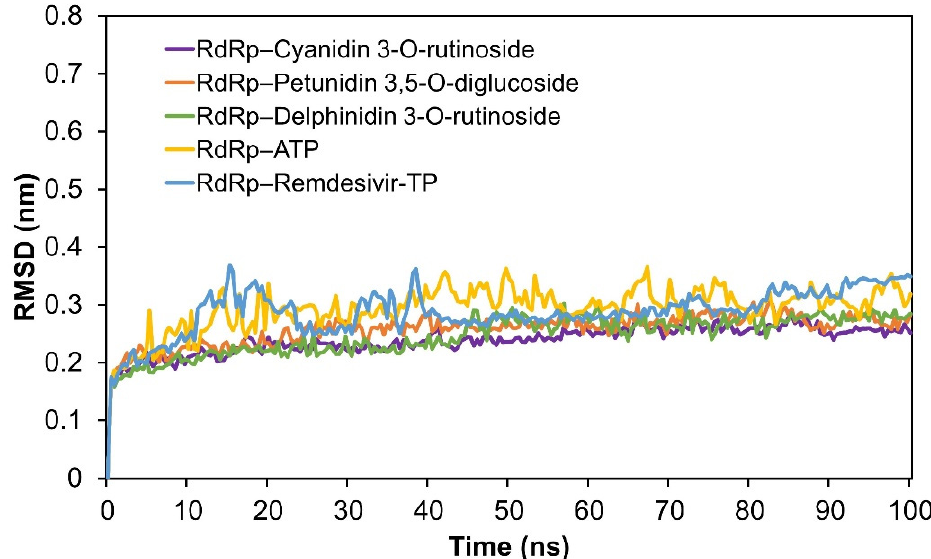
Figure 3. The comparison of the RMSD of protein–ligand complexes. The purple, red, green, yellow, and blue lines represent the RMSD of complexes of RdRps binding to cyanidin 3- O -rutinoside, petunidin 3,5- O -diglucoside, delphinidin 3- O -rutinoside, ATP and remdesivir, respectively.